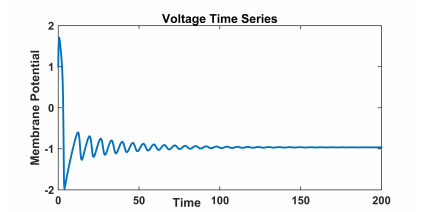
Figure 7. Responses of membrane potential with a constant external current value, I(t) = 1 µ A / cm 2 , a = 0.8 , b = 0.7 & c = 3